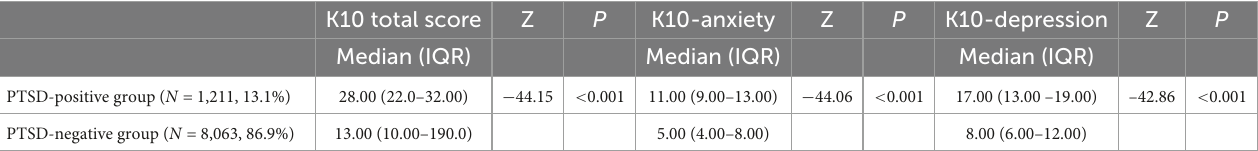
TABLE 2 Comparison of anxiety and depression scores between the PTSD symptoms positive group and PTSD symptoms negative group. K10 total score P